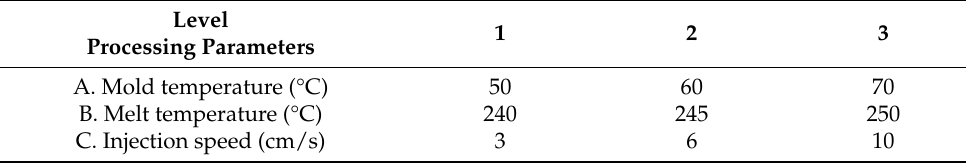
Table 1. The processing parameters and values in the experiments.